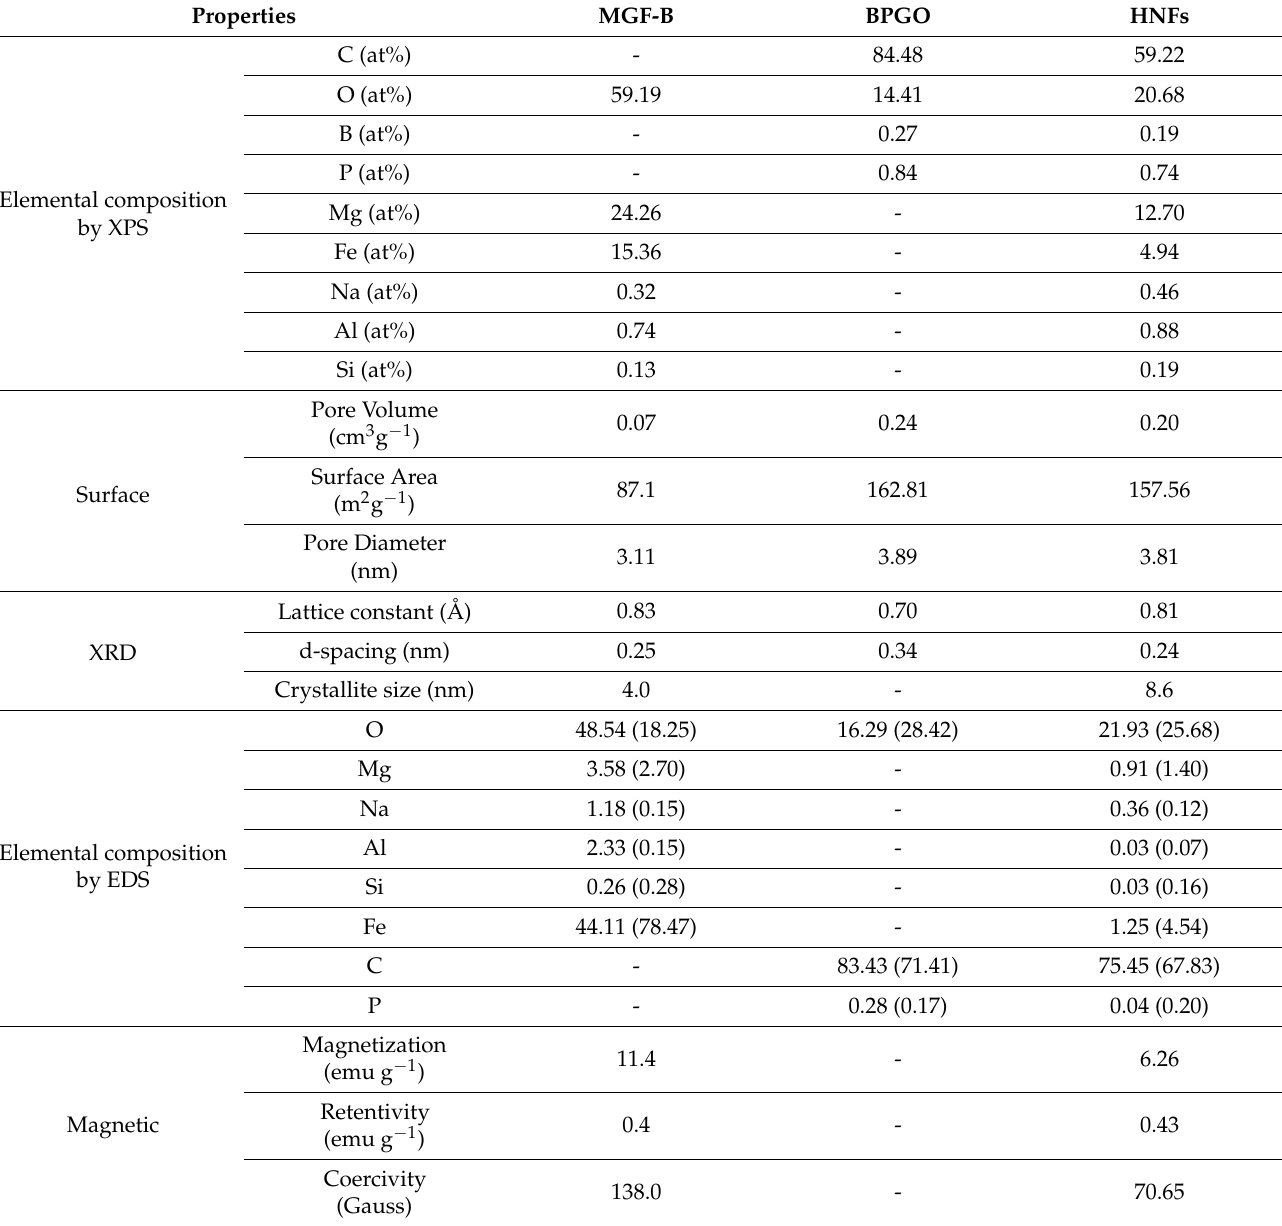
Table 2. Surface, magnetic, XRD parameters, and elemental composition by XPS and EDS